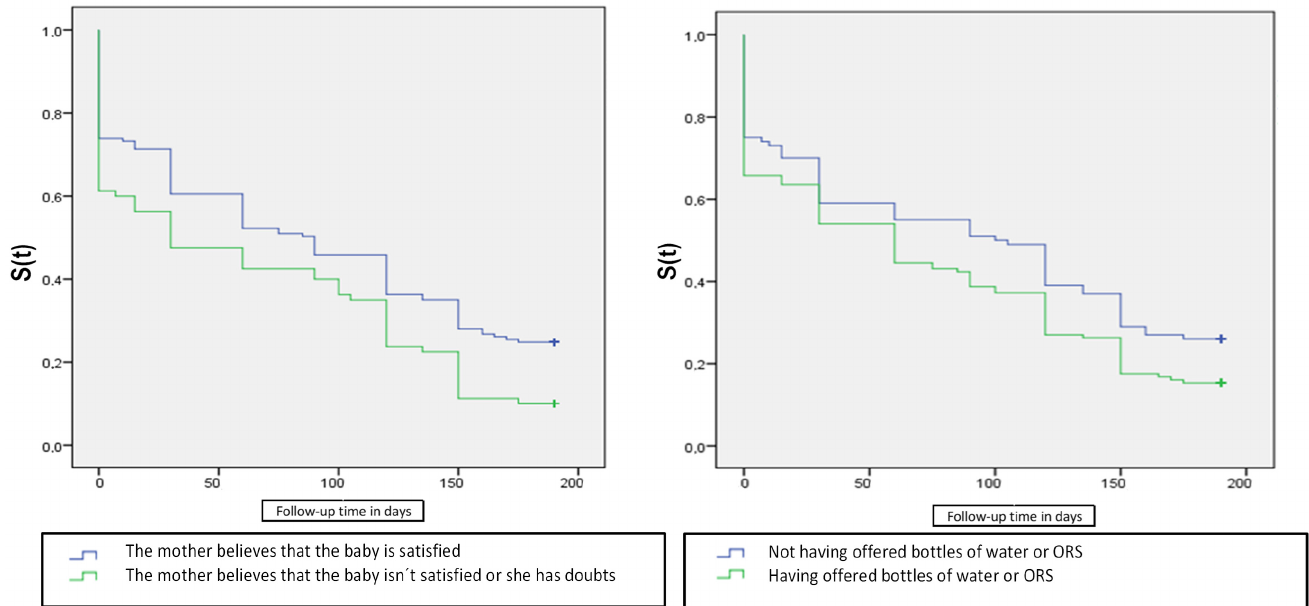
Figure 3. Kaplan–Meier curves of the duration of exclusive breastfeeding according to the mothers’ beliefs and supplementation with water or ORS in the breastfeeding process.